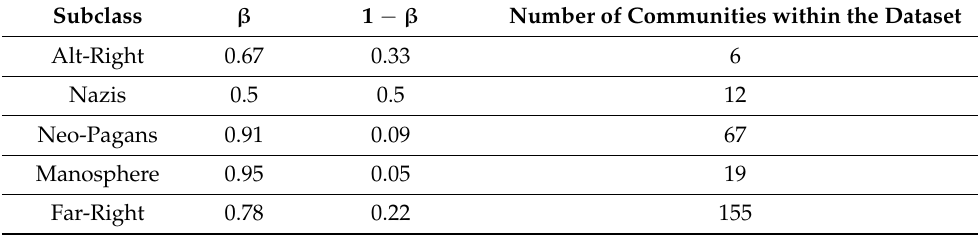
Table 1. Type II error and criterion power for different subclasses. Subclass β 1 − β Number of Communities within the